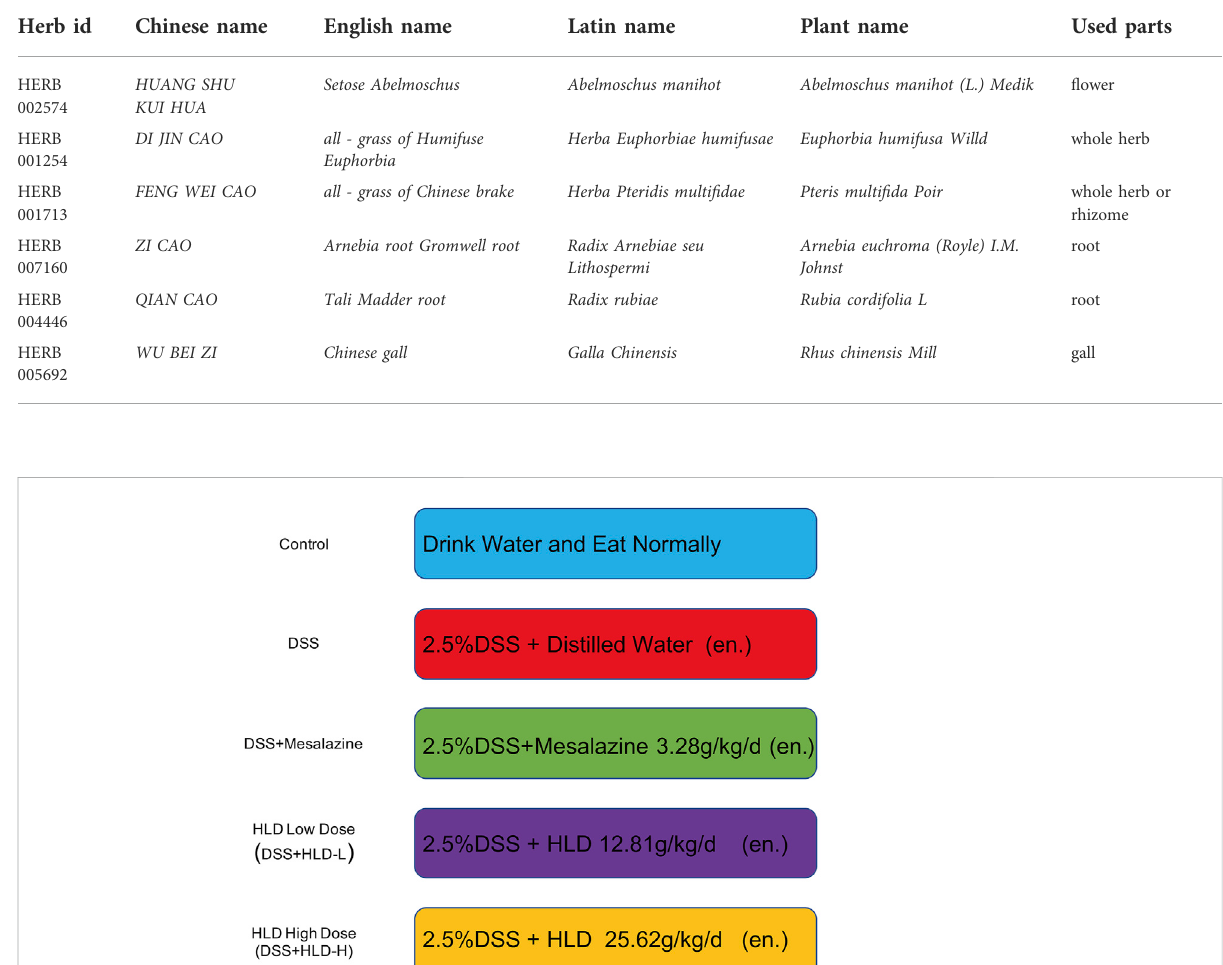
TABLE 1 Plant names and used parts of herbs included in the HLD.